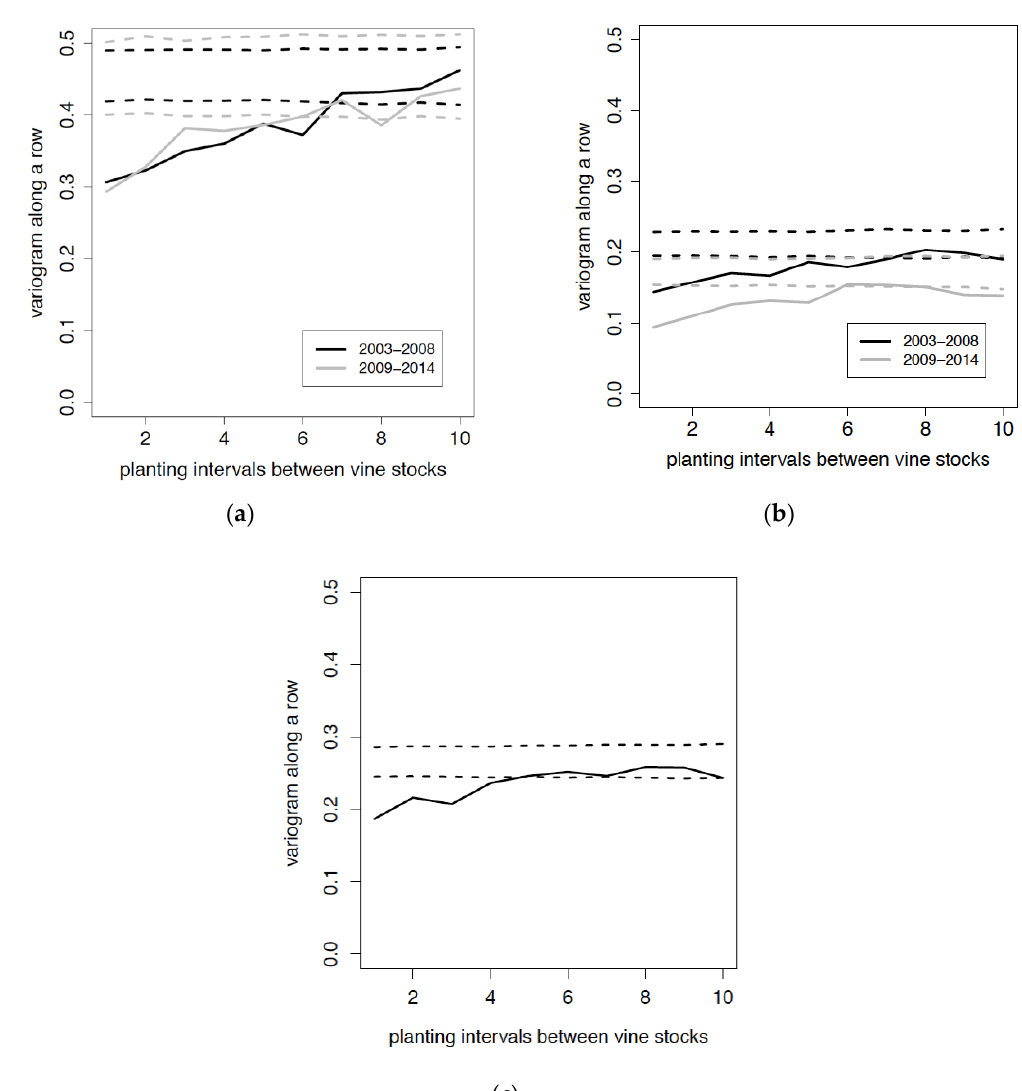
Figure 6. Estimated variograms and their confidence bands generated by permutation tests for spatial distribution of virus-infected vines in the Riesling plot. ( a ) GLRaV-1, ( b ) GVA. Black solid line: variogram on infected vines in 2003 – 2008. Grey solid line: variogram on infected vines in 2009 – 2014. ( c ) GLRaV-3 during the whole period 2003 – 2014. Dotted lines delineate the confidence bands at 95%. A spatial dependence between data is proven when the variogram (solid line) is outside the confidence band. x -axis: planting intervals between vine stocks; y -axis: value of the variogram along a row.